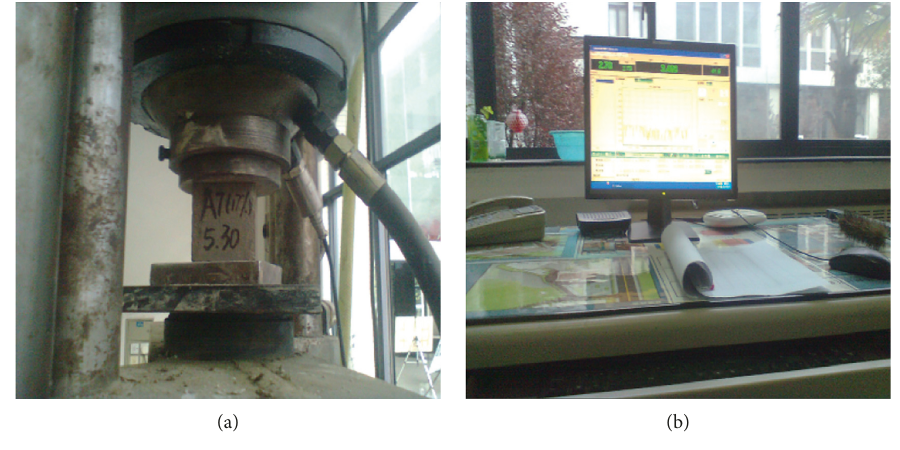
Figure 4: The compressive strength